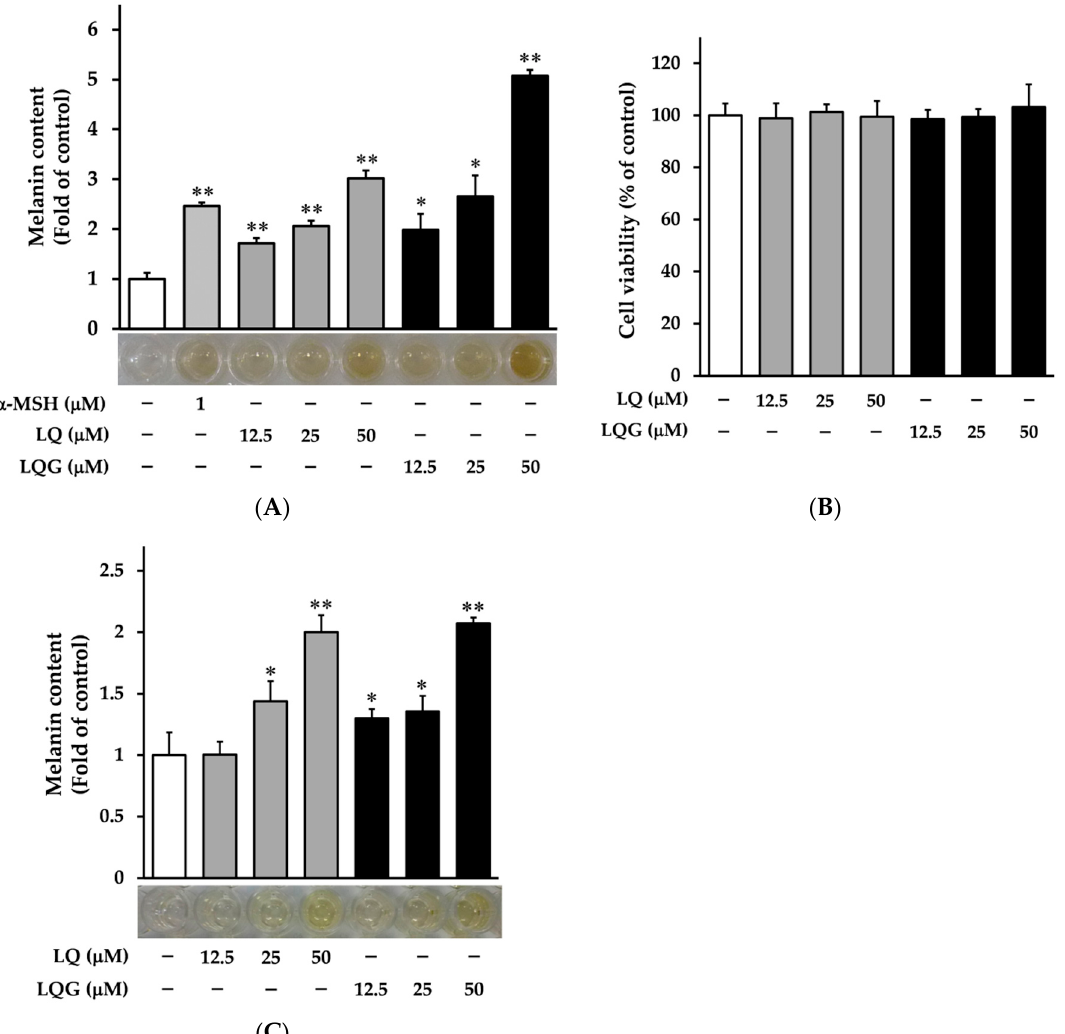
Figure 2. Effects of LQ and LQG on melanin synthesis and cell viability. ( A ) B16-F1 cells were treated with LQ, LQG, or α -melanocyte-stimulating hormone ( α -MSH) at the indicated concentrations for 72 h, and the melanin content was determined as described in Materials and Methods. ( B ) B16-F1 cells were treated with LQ or LQG at the indicated concentrations for 72 h, and the cell viability was determined as described in Materials and Methods. There were no significant differences between the control and experimental groups ( p > 0.05). ( C ) HMVII cells were treated with LQ or LQG at the indicated concentrations for 72 h, and the melanin content was determined as described in Materials and Methods. Values are the mean ± SEM of three independent experiments. ∗ p < 0.05 and ∗∗ p < 0.01 versus control.